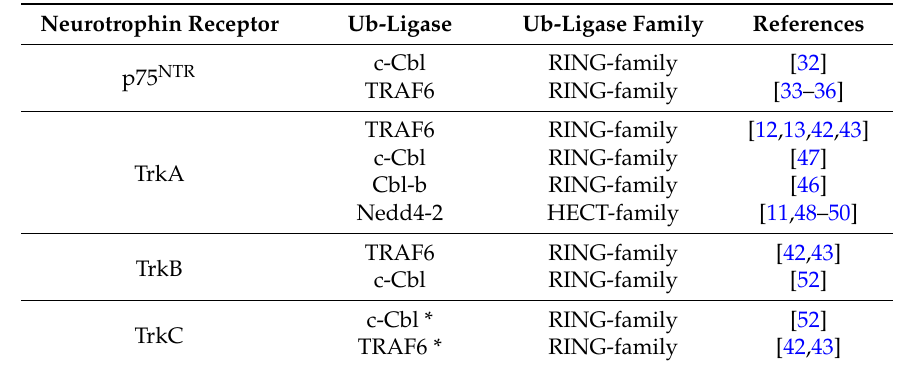
Table 1. Summary of the E3 Ub-ligases that participate in the ubiquitination of neurotrophin